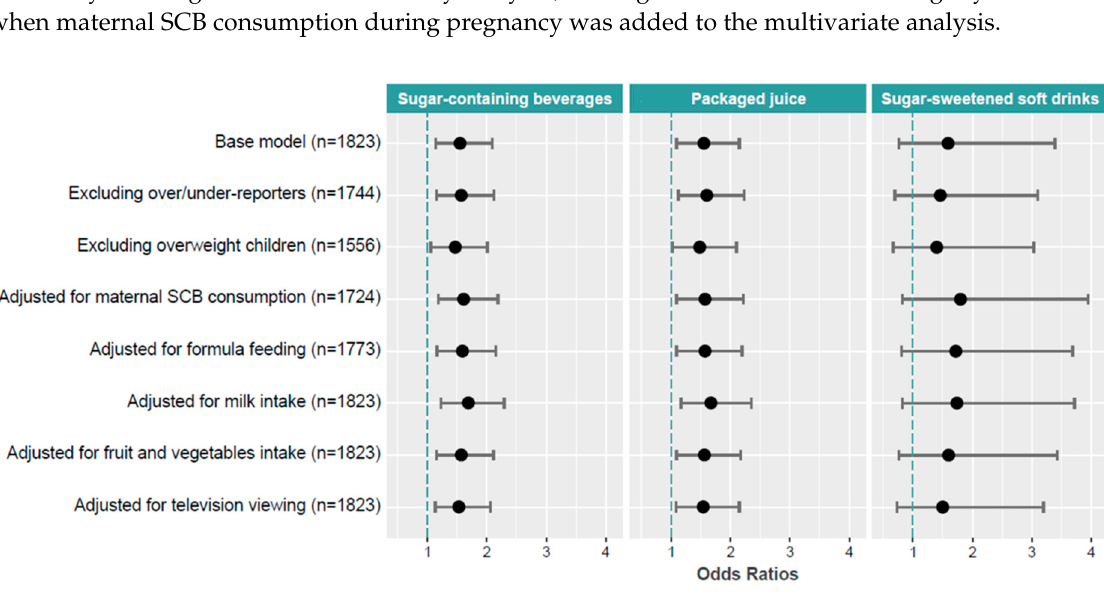
Figure 1. Sensitivity analyses for the association between sugar-containing beverages, packaged juice and sugar-sweetened soft drinks consumption and obesity based on model 3 of table 3.